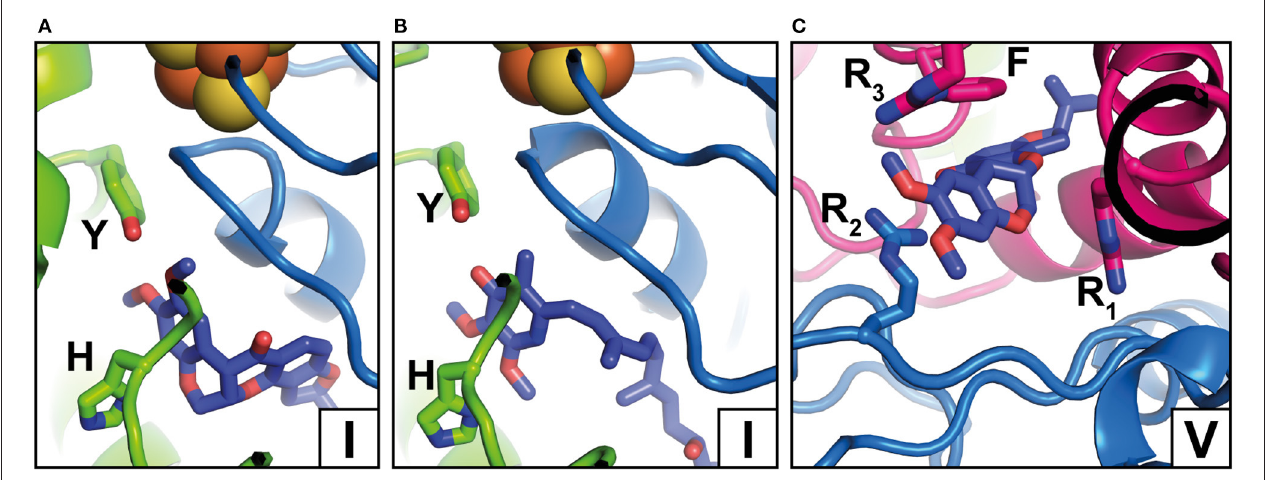
FIGURE 3 | Inhibitor binding positions. (A) Rotenone bound to complex I from O. aries in the closed state (PDB 6ZKK) (Y, Y108; H, H59); (B) Piericidin A bound to complex I from Mus musculus (PDB 6ZTQ) (Y, Y108; H, H59); (C) Rotenone bound to complex I from O. aries in the open state (PDB 6ZKL) (R 1 , R25; R 2 , R77, R 3 , R274; F, F224). Binding positions in the Q tunnel are indicated by Roman numbers and correspond to Figure 2A but note that rotenone occupies a larger area. For colors, see the legend of Figure 2 .